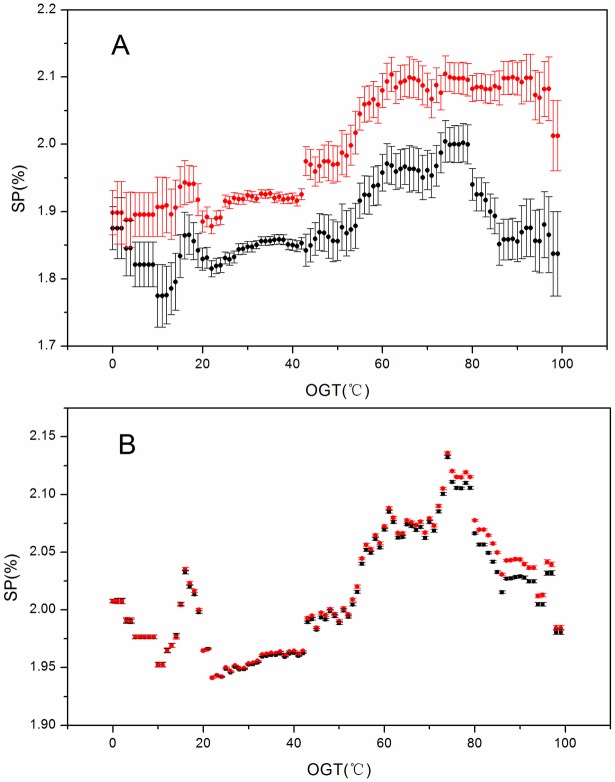
SP values against OGT.SP represents the proportion (%) of short-sequence-interval pairs with cut-off values of NS = 2 and NL = 6. (A) Calculated from a raw dataset. (B) Calculated from a random dataset. The black filled symbols correspond to the AB pair (unlike-charged residue pairs), and the red-filled symbols correspond to the AA/BB pair (like-charged residue pairs). Error bars represent a 95% confidence interval. A, Glu and Asp; B, Arg and Lys; NL, residue pairs separated by a long interval; NS, residue pairs separated by a short interval; SP, the fraction of residue pairs separated within a short interval.